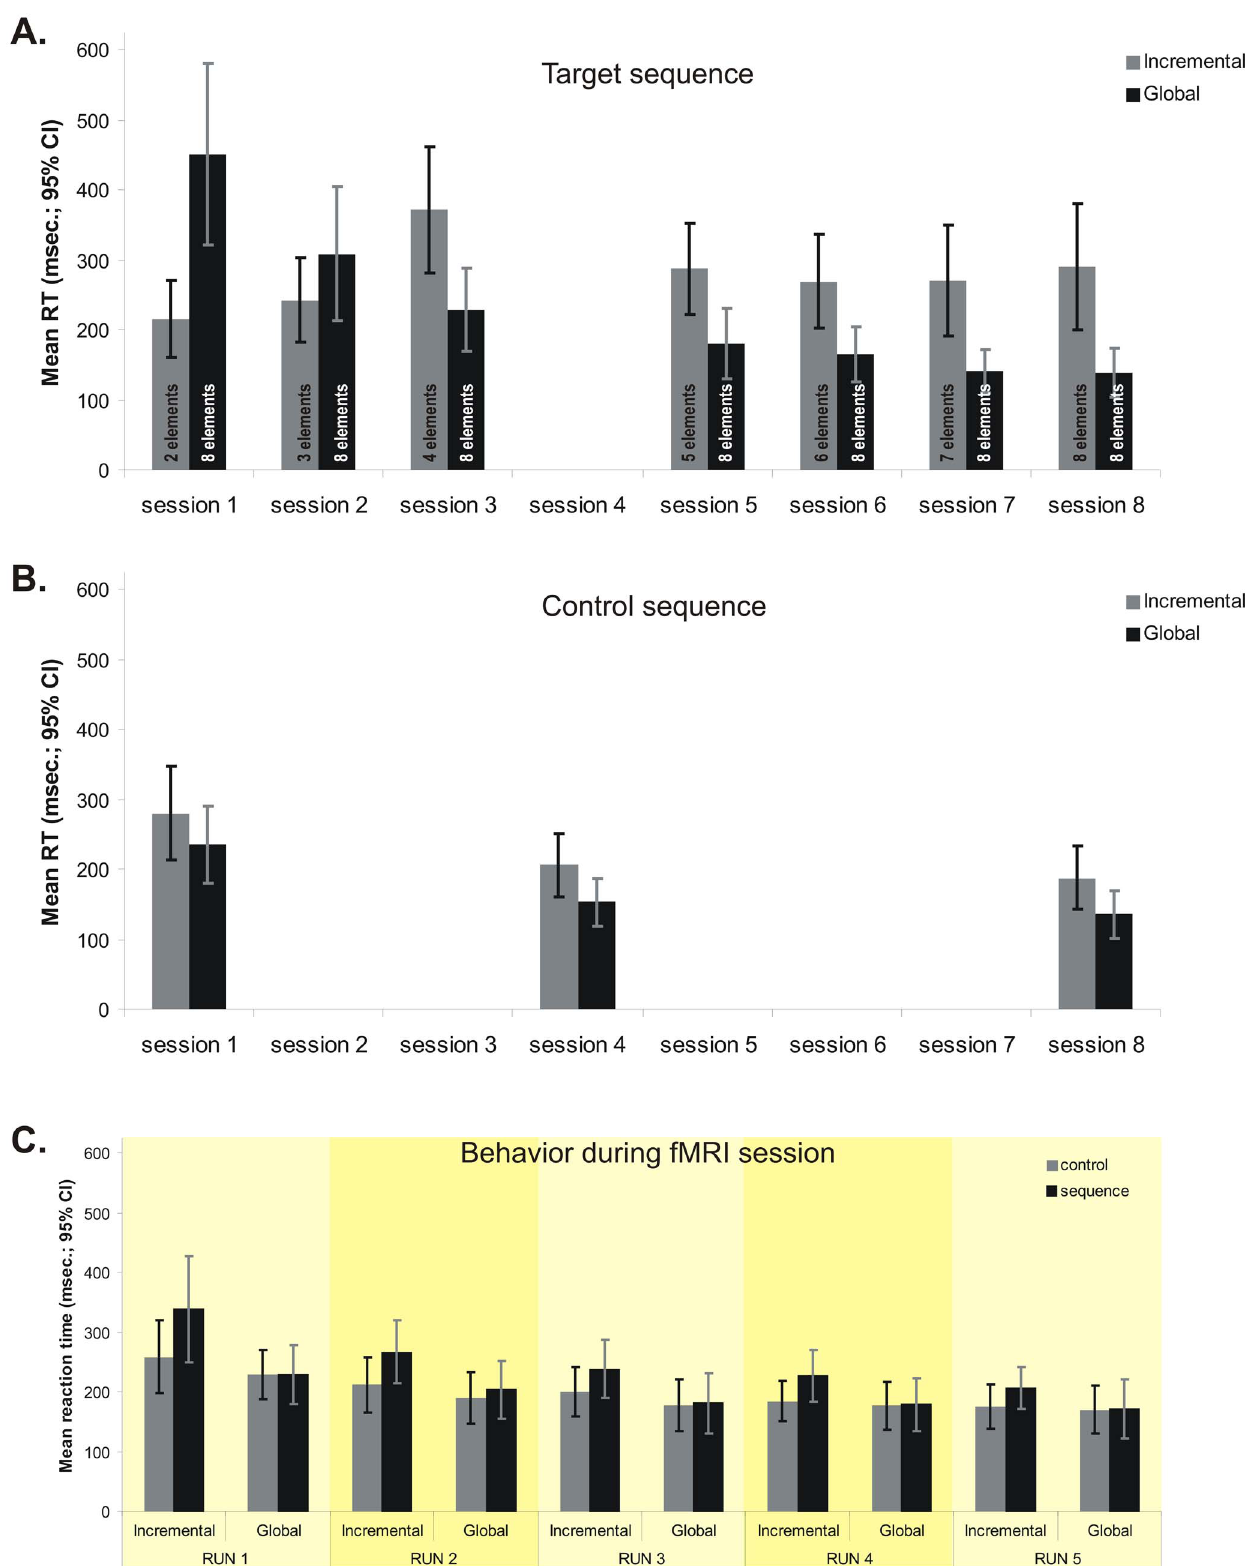
Figure 2. Behavioral results. A . Mean reaction time for the target sequence in the training sessions, for each group. B. Mean reaction time for the control sequence in sessions 1, 4 and 8, for each group. C. Mean reaction time for target and control sequences and for each group during the fMRI (9th) session.